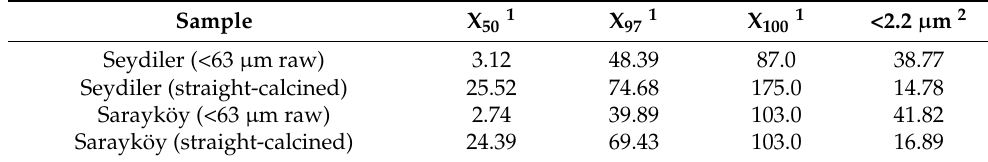
Table 2. Grain size analysis results of diatomite samples before and after straight-calcination.